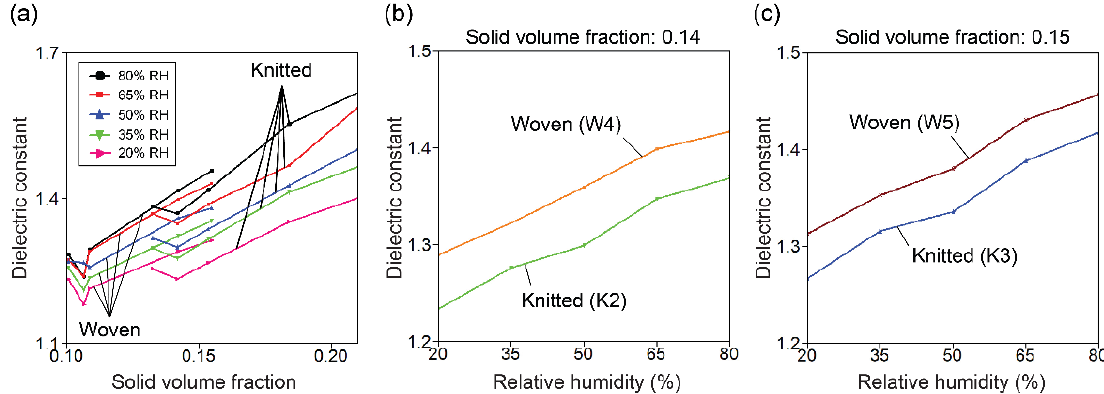
Figure 7. ( a ) Dielectric constants of woven and knitted cotton fabrics plotted as a function of the solid volume fraction; and comparison of the dielectric constants of woven and knitted cotton fabrics at various relative humidifies under the same solid volume fractions: ( b ) 0.14 and ( c ) 0.15. Adapted from [7] (pp. 8–9). Copyright 2020 YUSUKE MUKAI & MINYOUNG SUH.